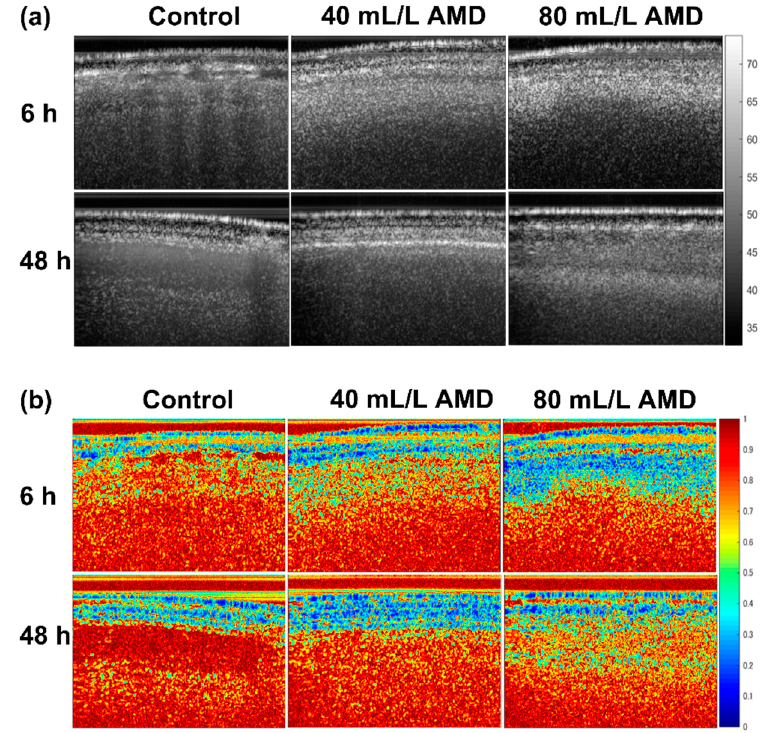
Figure 2. OCT images ( a ) and bOCT images ( b ) of soybean seed exposed in AMD for 6 and 48 h. A red region in the bOCT image corresponds to higher temporal fluctuations and a blue region to lower temporal fluctuations. There is greater activity or movement within the seed in the bOCT images with a higher red color density. A high blue color density, in contrast, indicates a lower level of biological activity or movement within the seed. Figure 2b (top row) showed more blue regions in the bOCT image of seeds treated with AMD for only 6 h compared to the control. Furthermore, there were more blue regions in the bOCT images of the 80 mL/L AMD-treated seeds than in the bOCT images of the 40 mL/L AMD-treated seeds after 48 h, and there were clearly more in both than in the control.